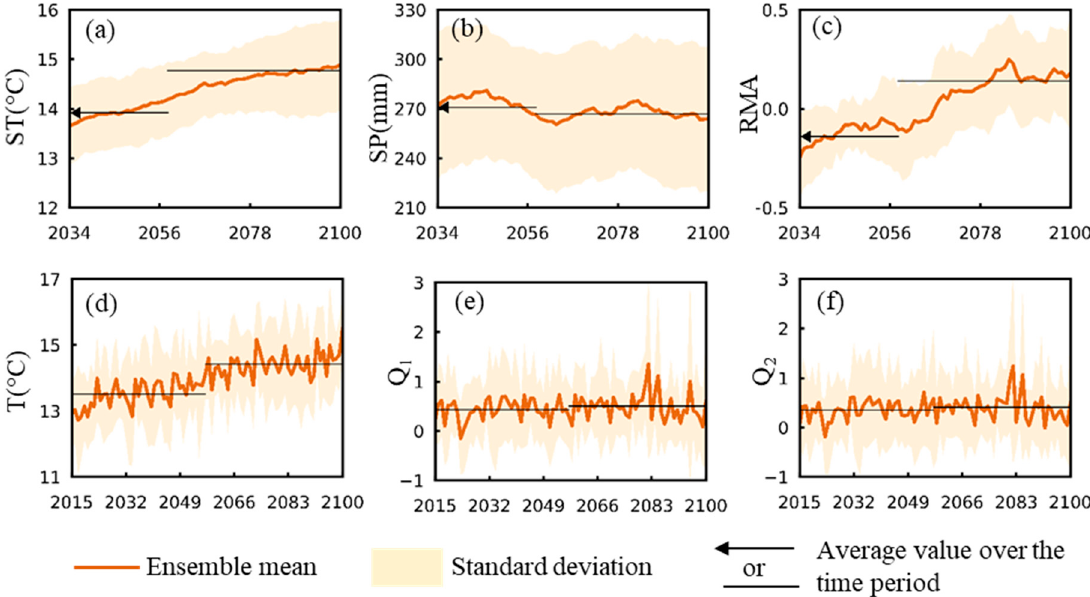
Figure 4. Projected ensemble mean results (orange line) ± 1 inter-model standard deviation (shaded areas) for the example of Dalarna county under the CMIP6 climate scenario SSP2-4.5. ( a ) Summer temperature (ST, °C), ( b ) summer precipitation (SP, mm), ( c ) standardized relative mosquito abundance (sRMA), ( d ) mean temperature (T) over 1–7 days before time t of the sRMA evaluation, along with maximum standardized river flows ( e ) Q 1 and ( f ) Q 2 over 36–42 days and 22–28 days before t, respectively. Results are shown in terms of 20–year running averages in ( a – c ), and in terms of annual average values in ( d – f ). Black lines show average values over the time periods 2015–2057 and 2058–2100. Supplementary Figures S1 and S2 show results for all counties corresponding to panels ( a – c ) and ( d – f ), respectively.